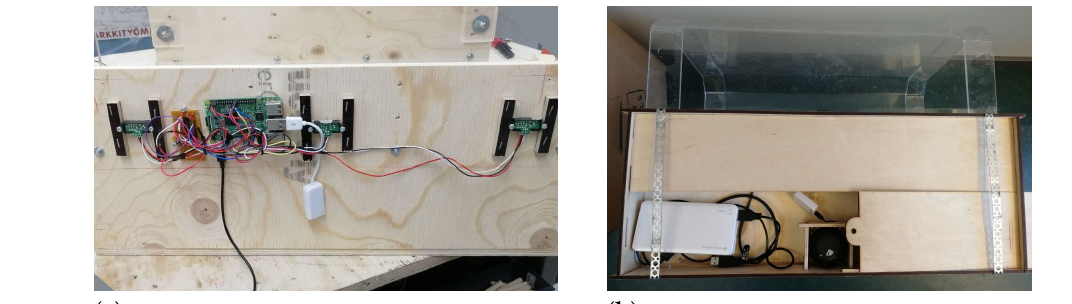
Figure 5. Electronics attached to the